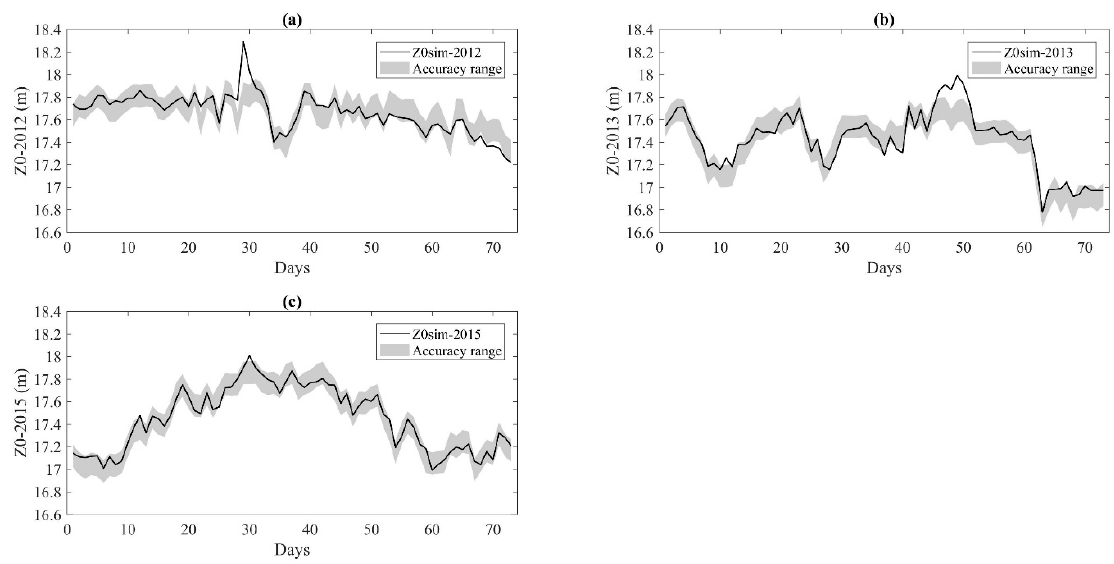
Figure 13. The simulated water level values contained in Z0 sim for the years 2012 ( a ), 2013 ( b ) and 2015 ( c ). As for PS, the vectors Z0 sim,y and Z0 obs,y were plotted (Figure 14) in order to detect the modelling impacts of the diff0 y elements. The intercept and the slope of the linear correlation were evaluated, and they were compared with the optimum values (i.e., perfect fitting) and with those reported for PS.